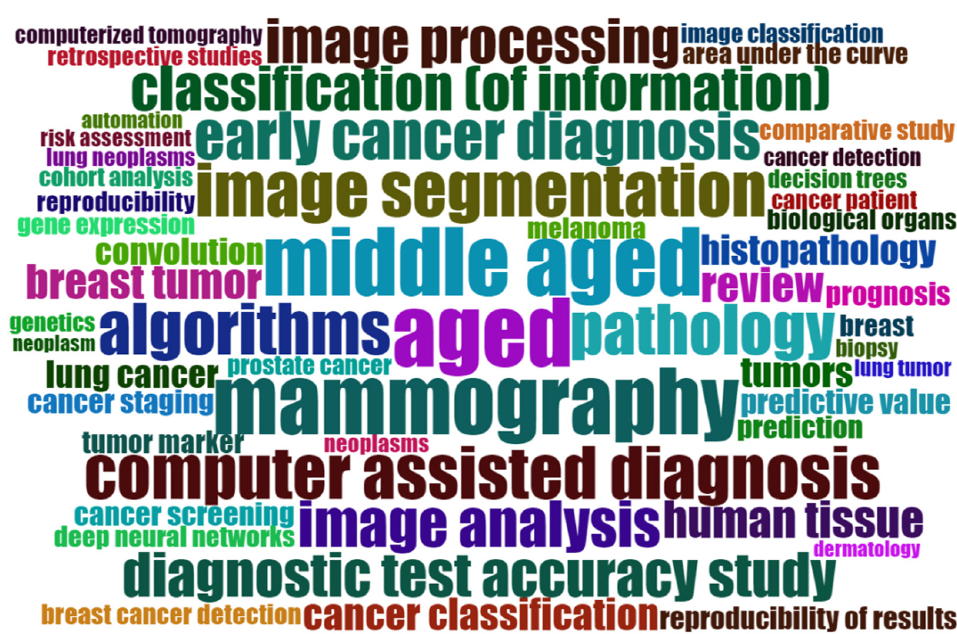
Figure 5. Word cloud of the most-frequently appearing keywords plus (generated with Bibliosh- iny).